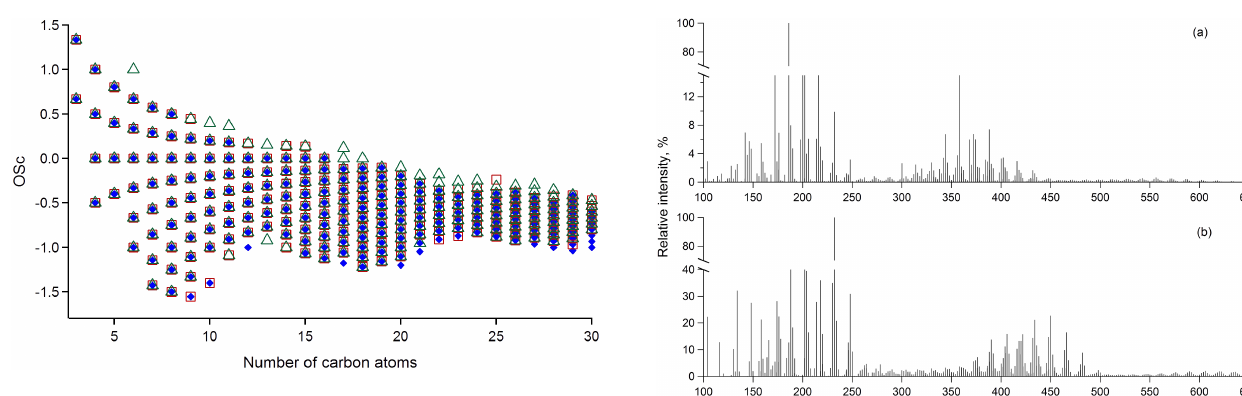
Figure 3. Carbon oxidation state of SOA from OH-initiated aging of aerosol from ozonolysis of BVOC mixture. Blue diamonds cor- respond to molecules in “fresh SOA”, red squares to “aged SOA” for 3h and green triangles to aged SOA for 9h.